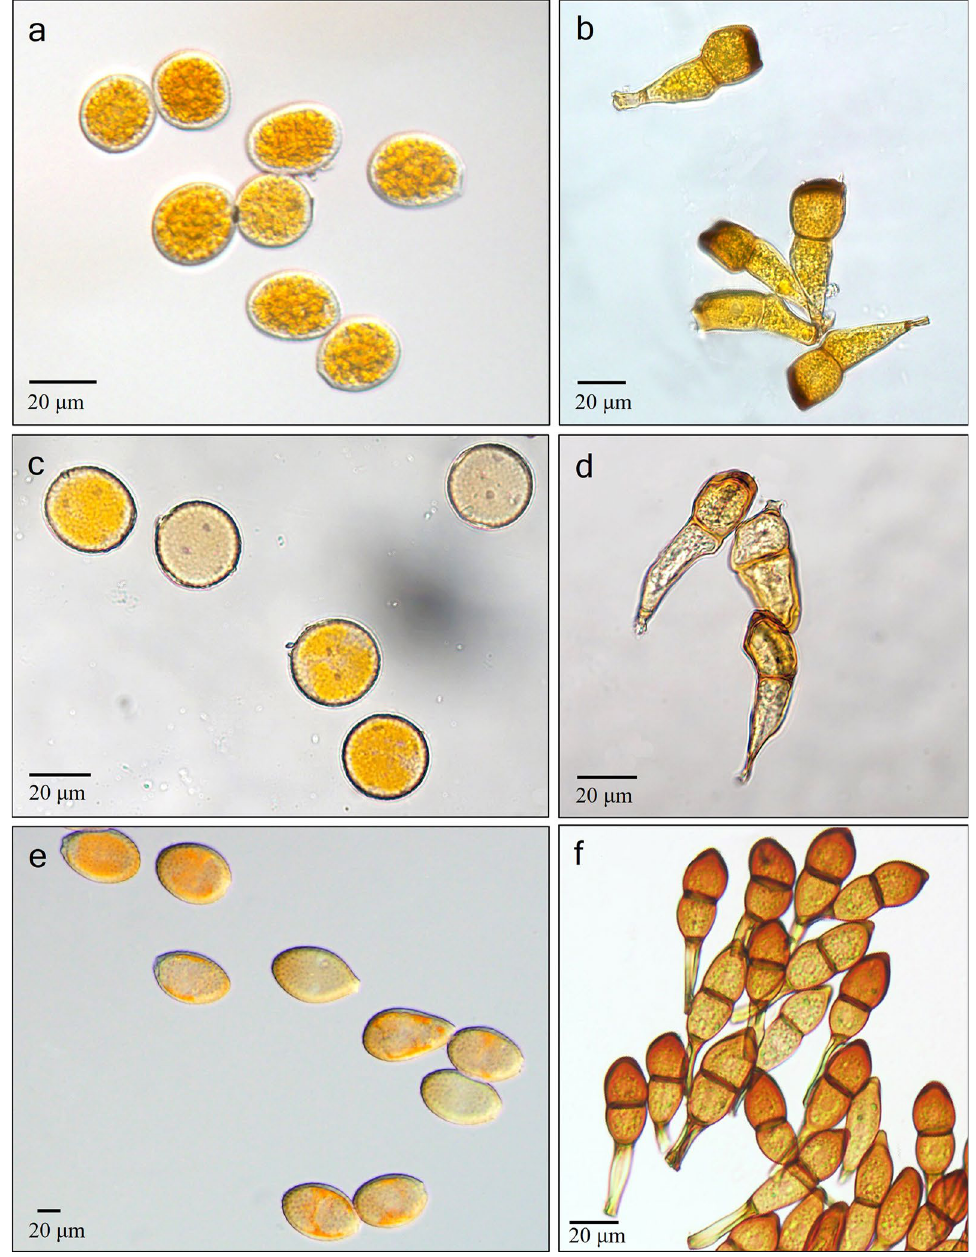
Fig. 4 Urediospores and teliospores of the wheat stripe, leaf, and stem rust fungus. a , b Urediospores ( a ) and teliospores ( b ) of Puccinia striiformis f. sp. tritici . c , d Urediospores ( c ) and teliospores ( d ) of Puccinia triticina . e , f Urediospores ( e ) and teliospores ( f ) of Puccinia graminis f. sp.